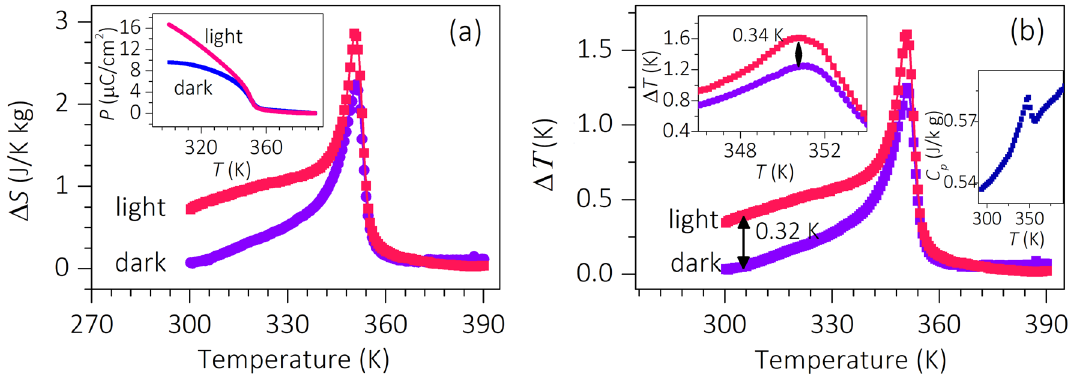
Figure 3. Photoelectrocaloric effect. Temperature-dependent ( a ) Δ S and ( b ) Δ T of BBLT sample measured under dark and light illumination conditions at + 30 kV/cm field. The insets show the respective P versus T curve, an enlarged version of Δ T versus T plot near T C , and temperature-dependent heat capacity of the sample.